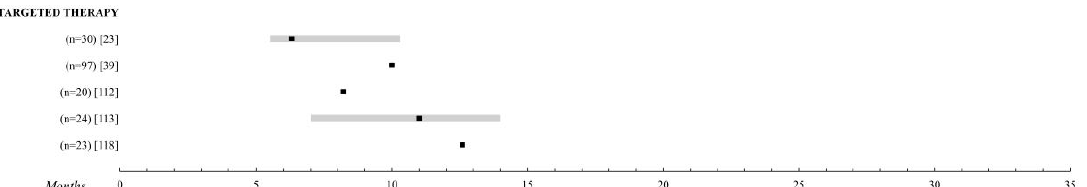
Figure 4. Targeted therapy. Comparison of the overall survival of the different treatments for metastatic UM. Those studies with n > 20 patients were selected. The black square indicates the median, the 95% confidence intervals are the grey bar. The range is established by the black lines. The overall survival is shown up to 35 months; when it is extended, the maximum time data (in months) is added.